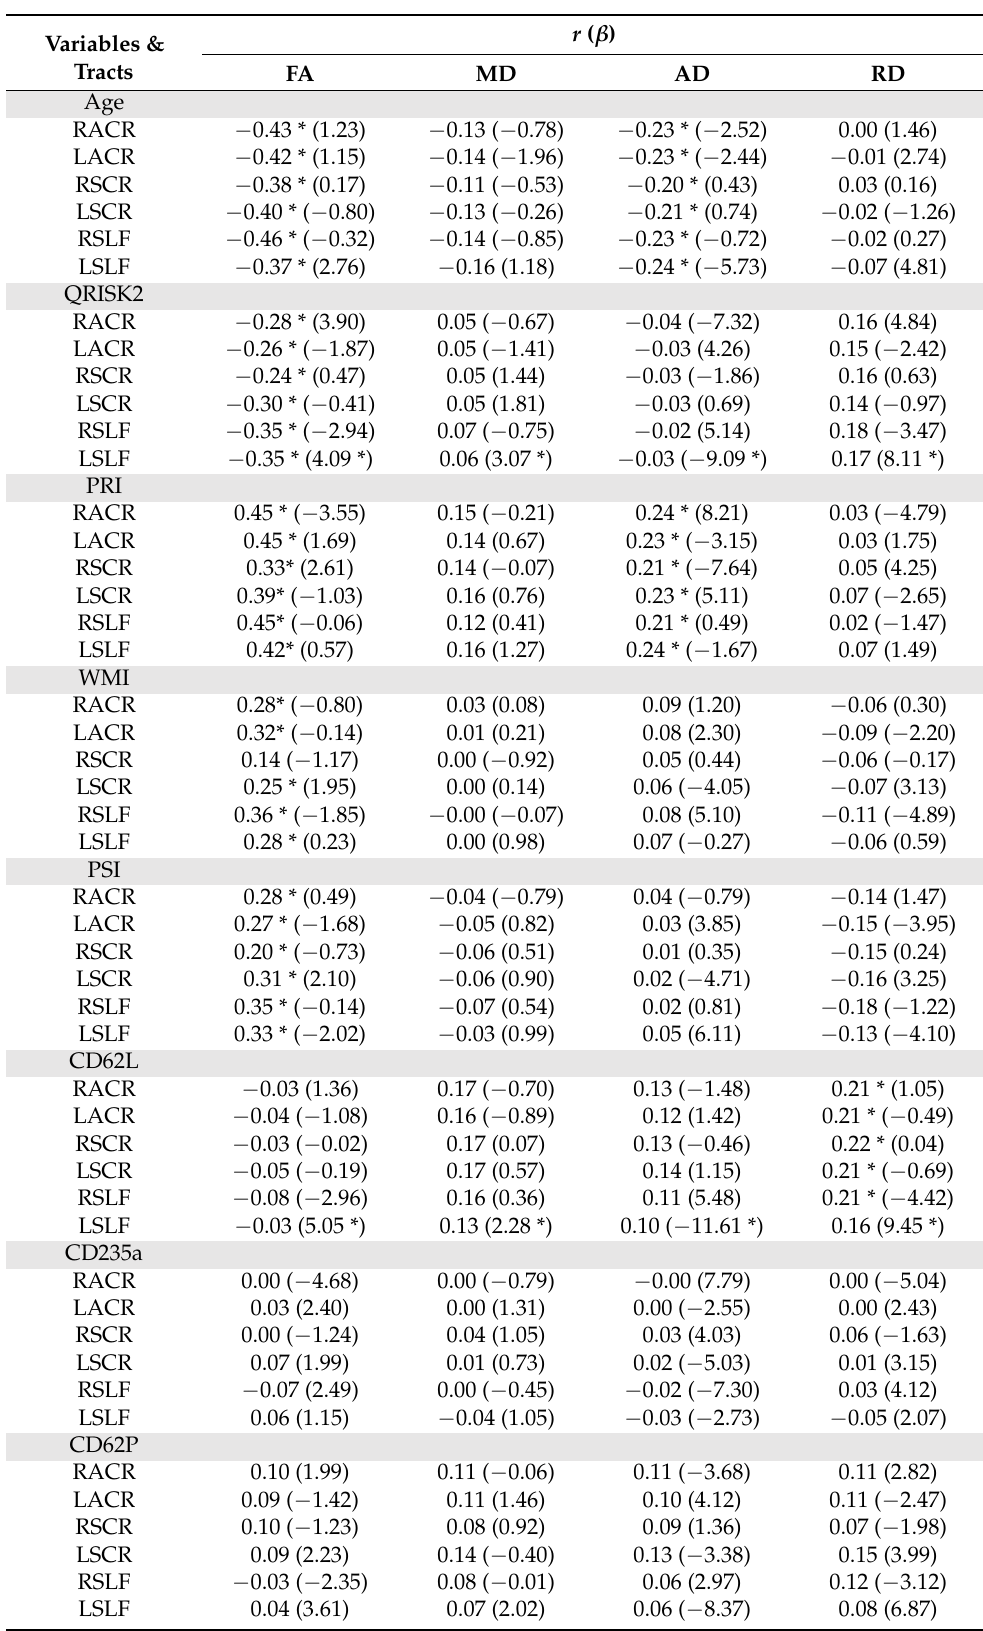
Table 5. Correlation and multiple linear regression profile of study variables with white matter